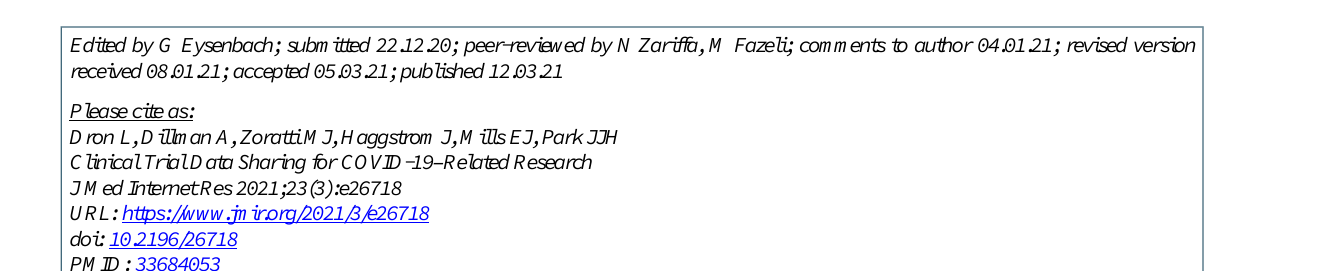
ICODA: International COVID-19 Data Alliance IPD: individual participant-level